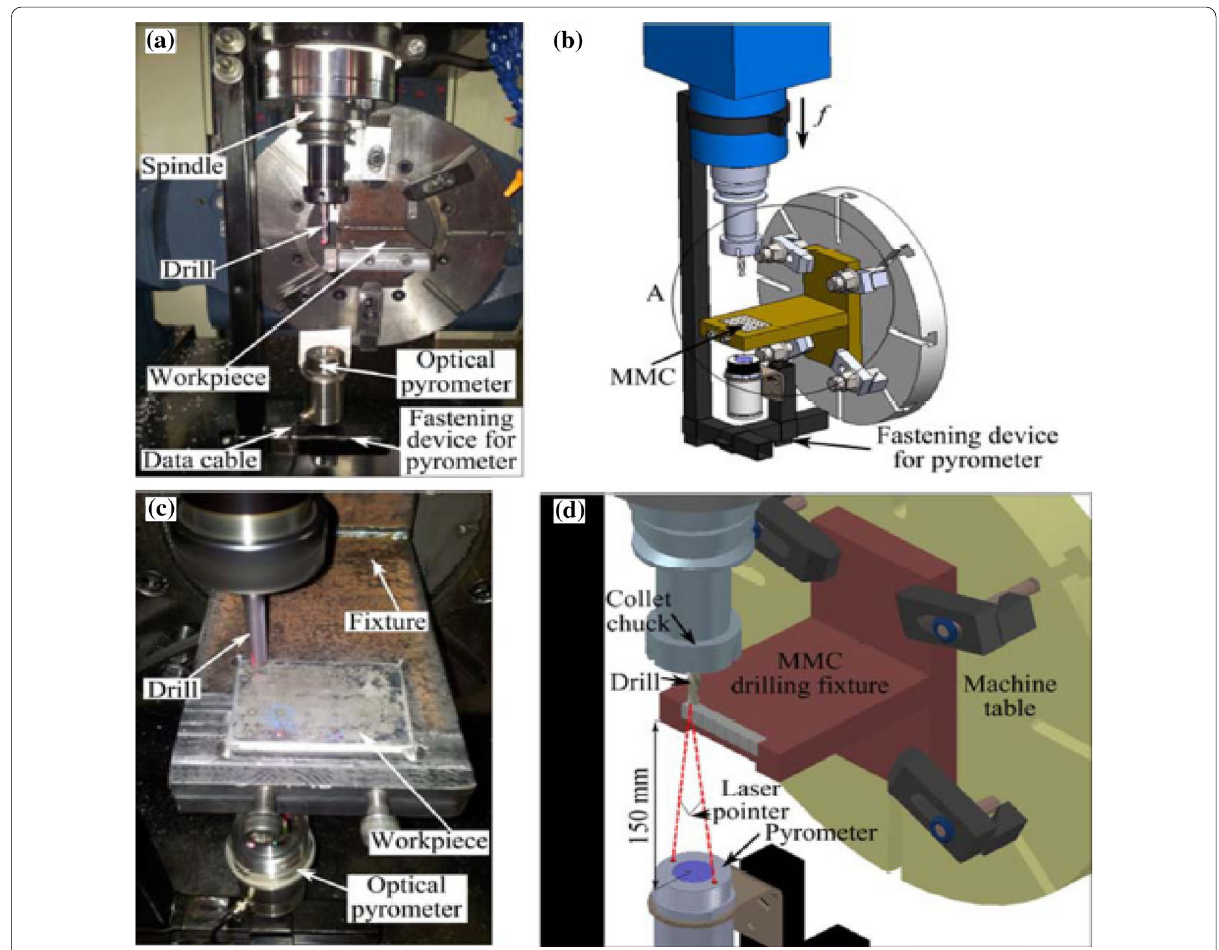
Figure 9 Test setup for temperature measurement: a Picture of test setup, b Solid model view of test setup, c Detail of A (Test setup), d Detail of